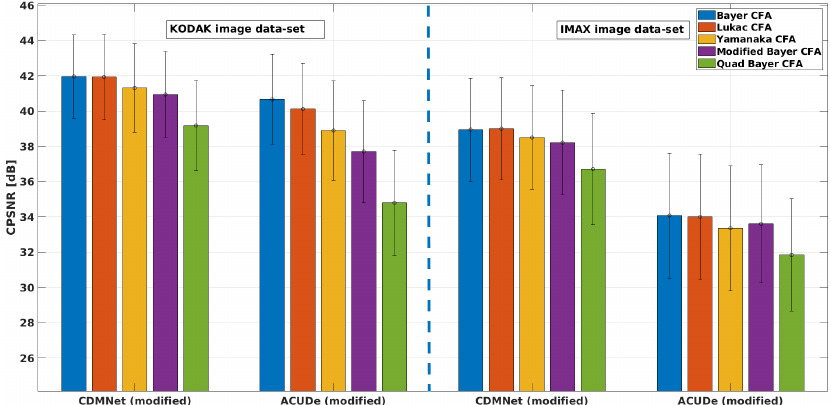
Figure 5. Average color peak signal-to-noise ratio (CPSNR) results with standard deviation of the mean: for the two modified generic algorithms (“CDMNet modified” and “ACUDe modified”), for the two data-sets (“KODAK” and “IMAX”), for five different Bayer-like patterns (Bayer, Lukac, Yamanaka, Modified Bayer and Quad Bayer).